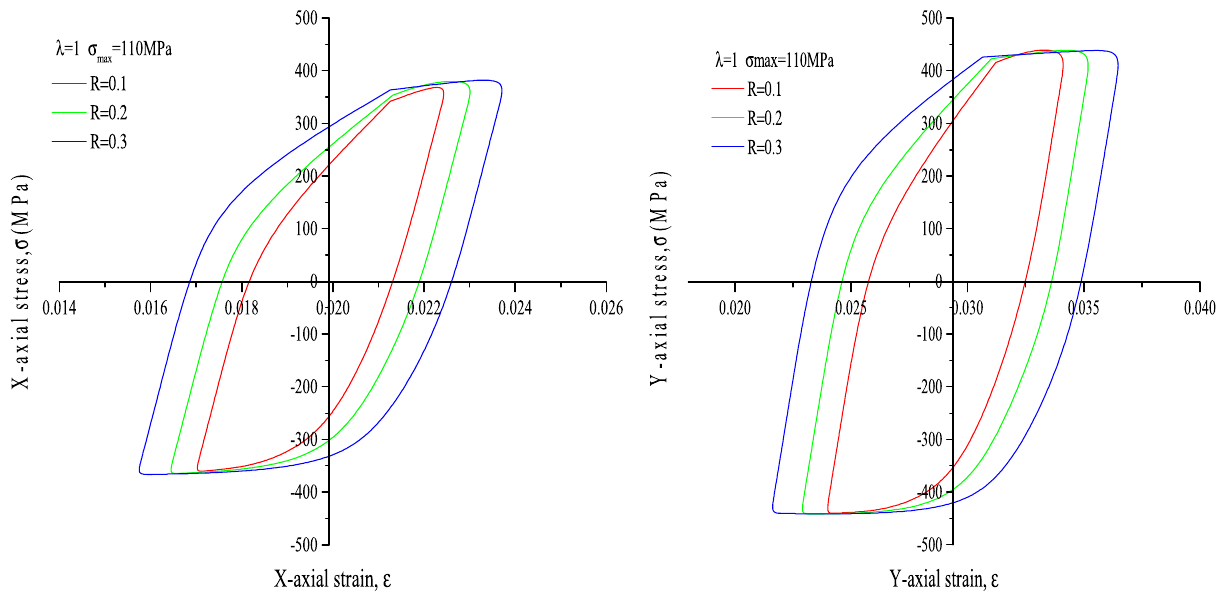
Fig. 7 Hysteresis loops of X - and Y -axis stress and strain with different stress